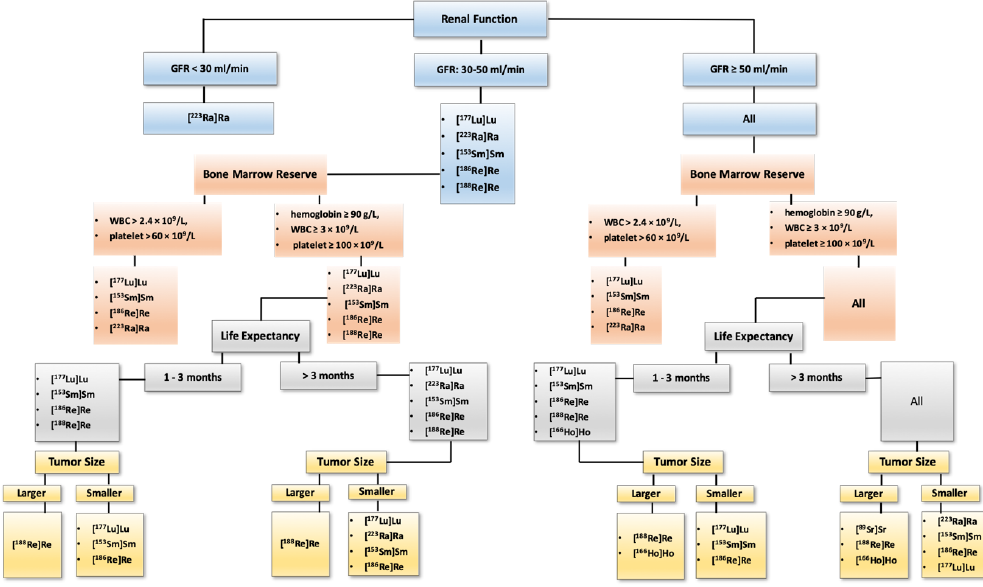
Figure 4. A proposed algorithm for selecting an appropriate radiopharmaceutical for bone-pain palliation therapy. Bone-pain palliation with radiopharmaceuticals is offered when the metastatic